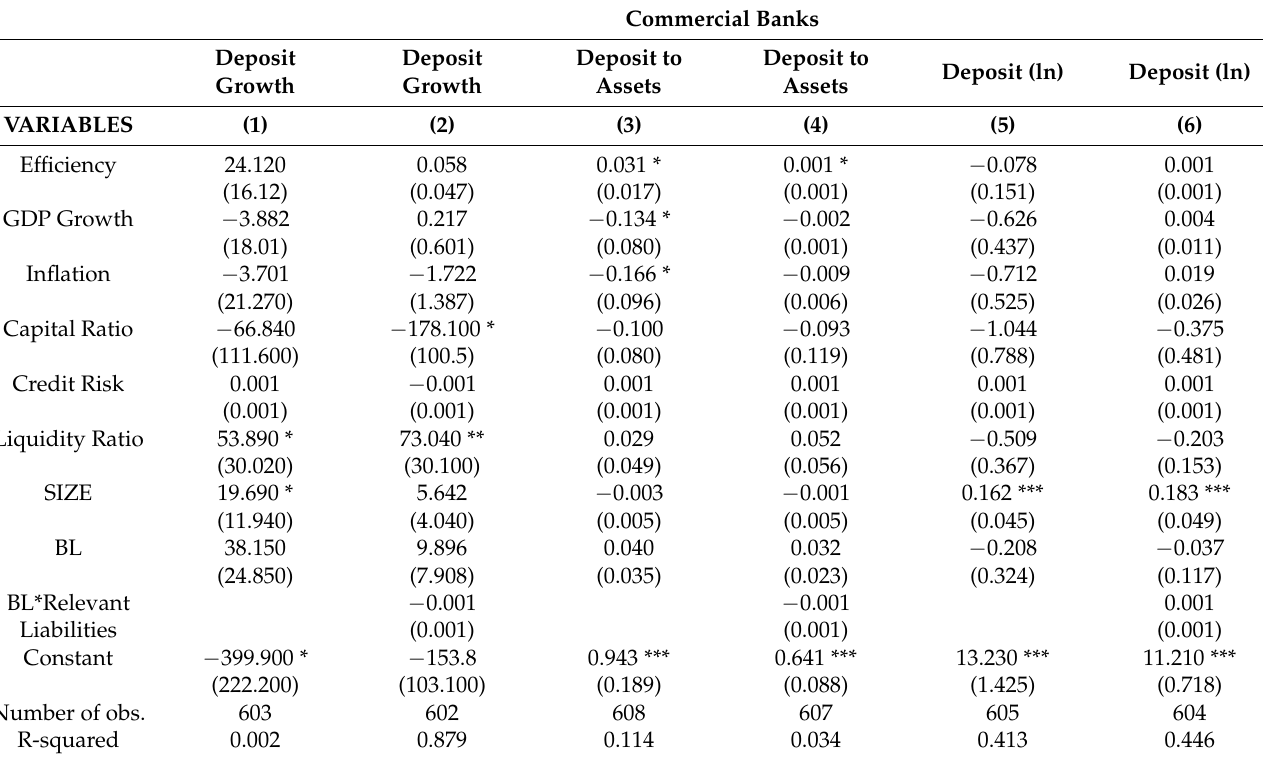
Table A6. Data presenting estimates based on GLS regressions with a random effect on all German commercial banks. Symbols *, **, and *** represent statistical significance at the levels of 10%, 5%, and 1%,